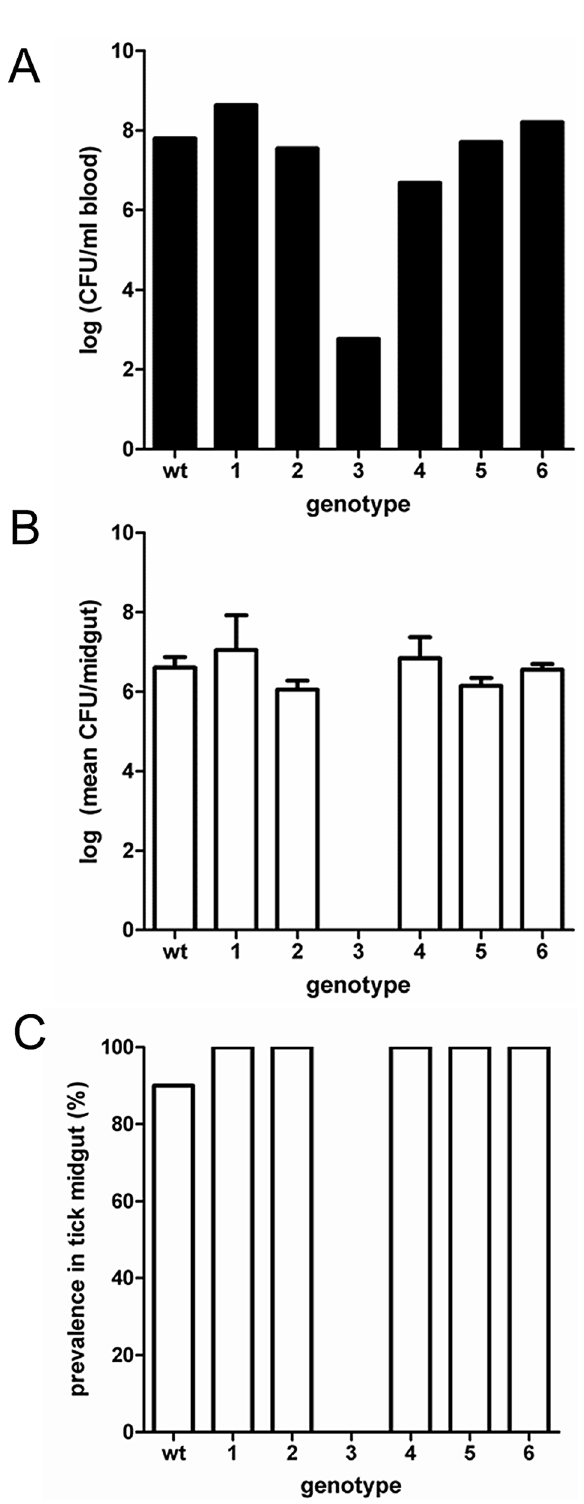
Figure 2. Genotype prevalence and bacterial levels during single-genotype infections. Six genotypes were investigated for their ability to colonize mice and ticks in the absence of other genotypes. A) Bacterial infection level in mouse blood. B) Bacterial infection level in tick midgut. C) Prevalence of genotype colonization in tick midguts. Error bars represent 6 SEM.